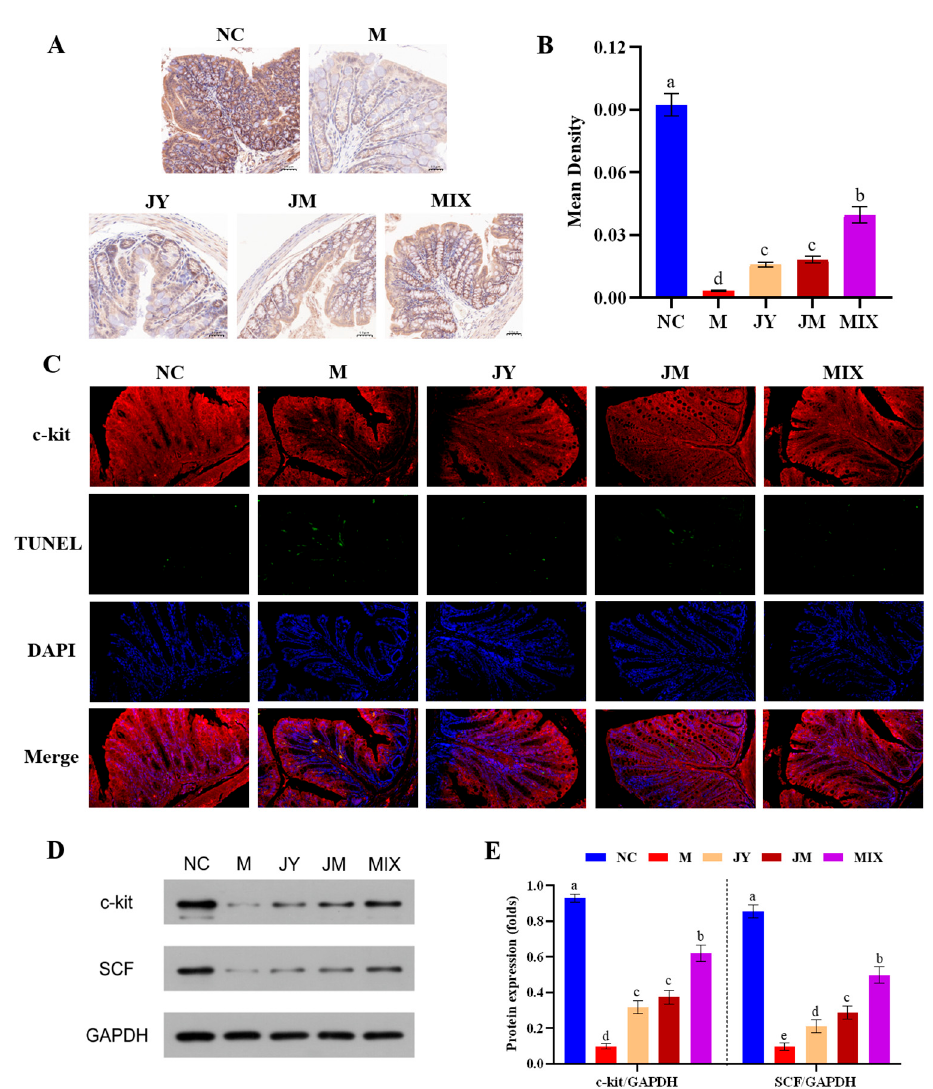
Figure 4. Description of interstitial cells of Cajal (ICC) and expression of c-kit and SCF protein in colon: ( A ) ICC distribution in colon (200 × ); ( B ) the Mean Density of c-kit in colon; ( C ) ICC apoptosis in colon (200 × ); ( D ) blot images of c-kit and SCF; ( E ) expression of c-kit and SCF protein. Different letters (a, b, c, d and e) denote significant differences between different groups of mice ( p < 0.05). NC stands for the normal control group, M for the model group, JY for the L. paracasei JY062 group, JM for the L. gasseri JM1 group, and MIX for the combination